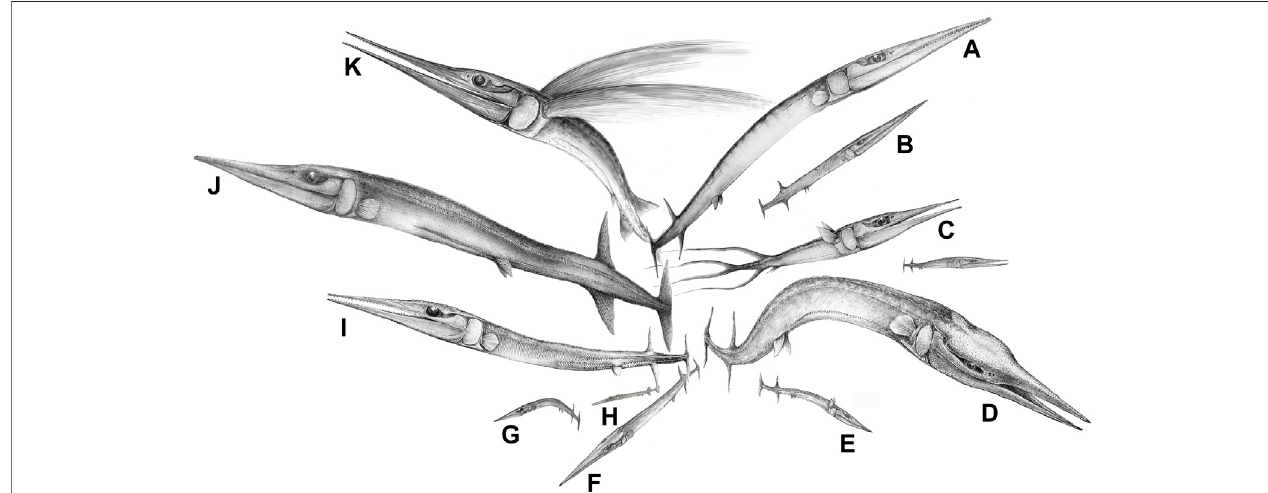
FIGURE3| Thediversi fi cationofthesaurichthyiform fi shes( ‘ lizard fi sh ’ )intheMiddle TriassicofSouthChina(easternpaleo-Tethys),re fl ecting theestablishmentof a complexly tiered marine ecosystem (or marine fi sh communities) with intensive predator-prey interactions along the food chains. Species list: (A) , Saurichthys dawaziensis ; (B) , Saurichthys sp. 1 (under description); (C) , Sinosaurichthys longimedialis ; (D) , Yelangichthys macrocephalus ; (E) , Sinosaurichthys sp. (under description); (F) , Saurichthys sp. 2; (G) , Sinosaurichthys minuta ; (H) , Saurichthys spinosa ; (I) , Saurichthys yunnanensis ; (J) , Saurichthys yangjuanensis , which preyedonthecoexistingSinosaurichthyslongipectoralis(see,Wuetal.,2015); (K) ,Sinosaurichthyslongipectoralis. A,C,E – I fromtheAnisianoftheLuopingBiota; D,J,K from the Anisian of the Panxian Biota; B from the Ladinian of the Xingyi Biota. Artwork by Fei-xiang Wu.